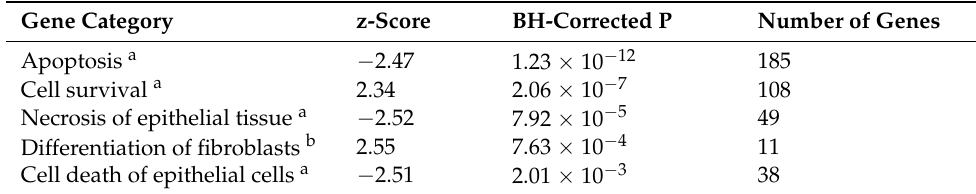
Abbreviations: POP, pelvic organ prolapse; BH, Benjamini-Hochberg. a This gene category falls under the broader ‘cell death and survival’ category. b This gene category falls under the broader ‘connective system development and function’